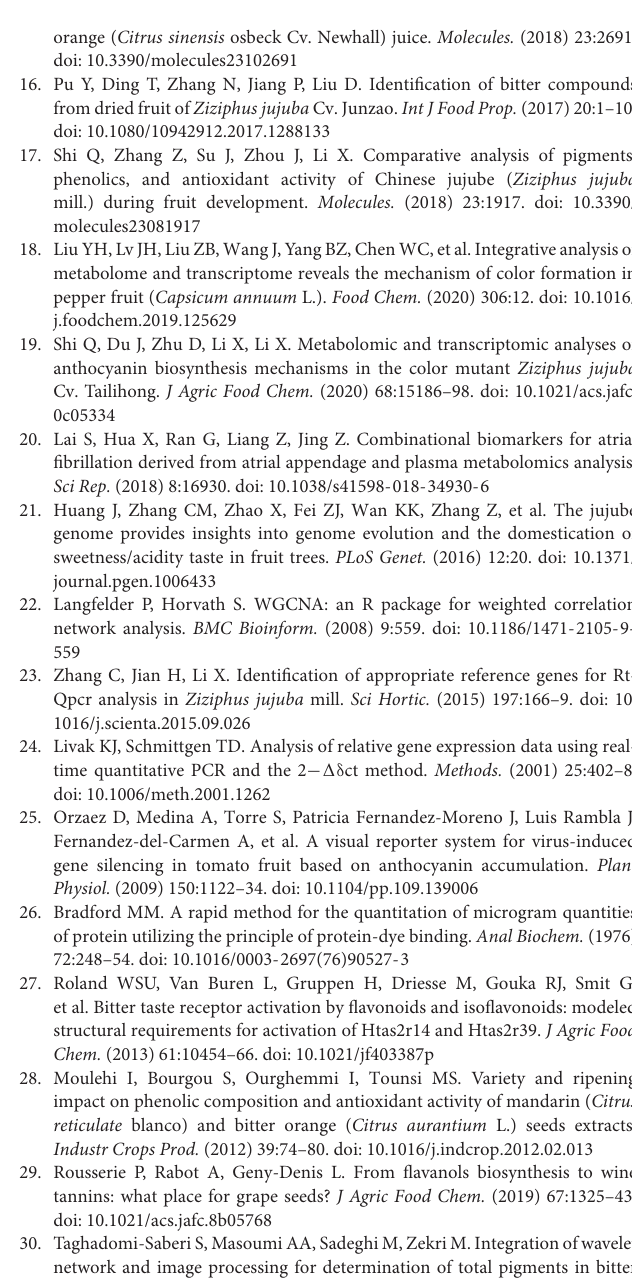
Supplementary Figure 2 | Volcano plot of the genes in the fruit skins of the cultivars ‘Junzao’ in this comparison group of DAP90 vs DAP50, DAP110 vs. DAP50 and DAP110 vs DAP90. Supplementary Figure 3 | Enrichment analysis of GO term in differentially expressed genes. (A) DAP90 vs. DAP50, (B) DAP110 vs. DAP50, (C) DAP110 vs. DAP90. Supplementary Figure 4 | Relative expression levels of flavonoid synthesis pathway genes in jujube skins at different developmental stages. The R 2 is the square of Pearson’s correlation